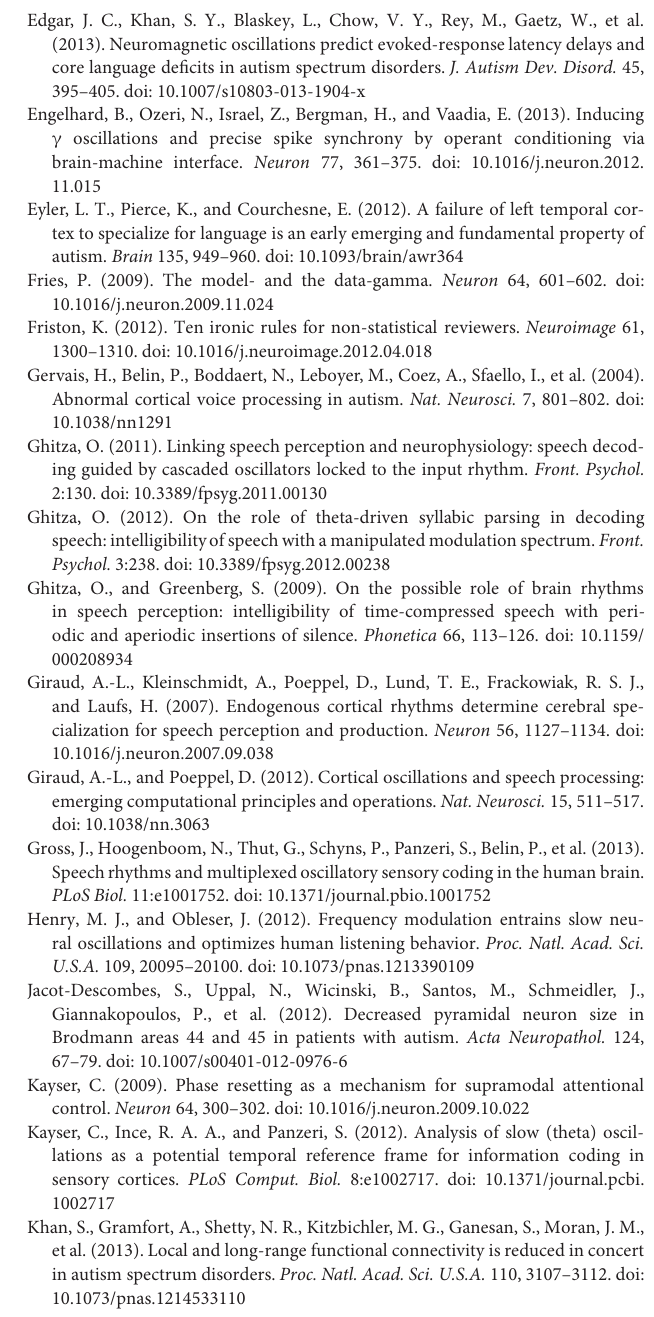
Figure S1 | Whole brain topography of theta-BOLD (top) and low-gamma-BOLD (bottom) effects in controls (left) and subjects with autism during the movie (whole brain, p < 0.01 uncorrected; whole brain,